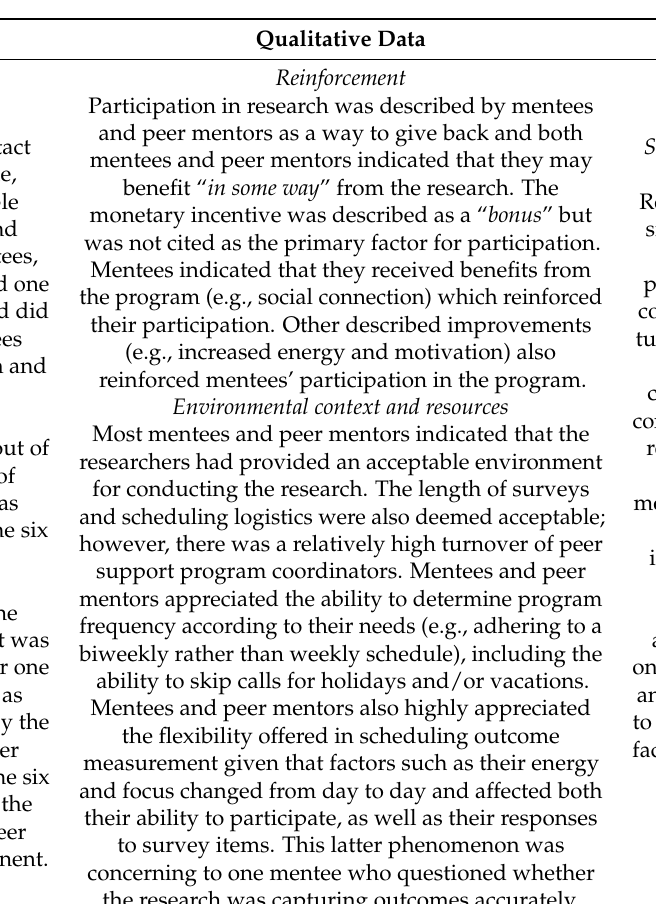
Table 8. Joint display of quantitative data, qualitative data, and integrated findings for main study